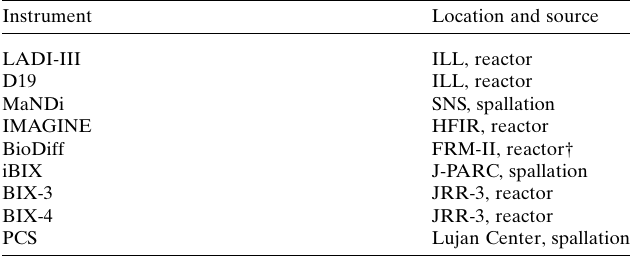
Table 4 Macromolecular neutron crystallography instruments.